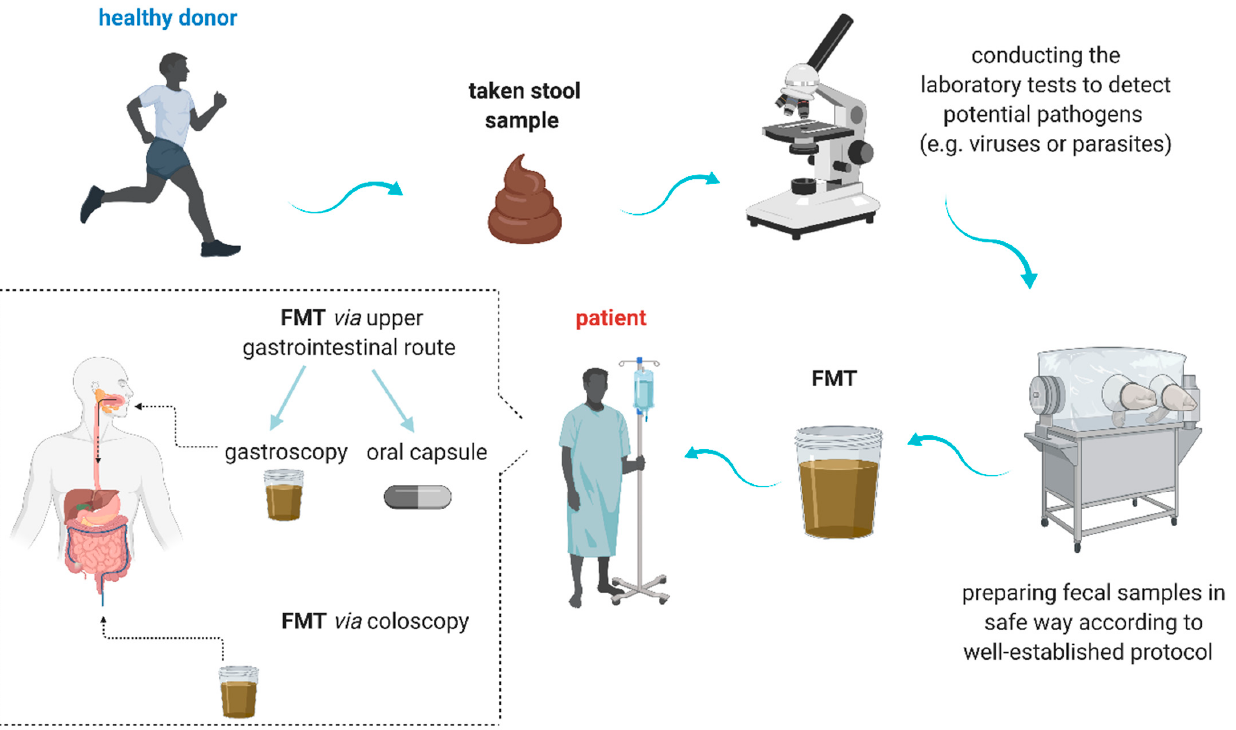
Figure 1. Fecal gut microbiota transplantation procedure [1,9,51,52]. FMT—fecal microbiota transplantation. Table 1. Most common preliminary tests for FMT [51].